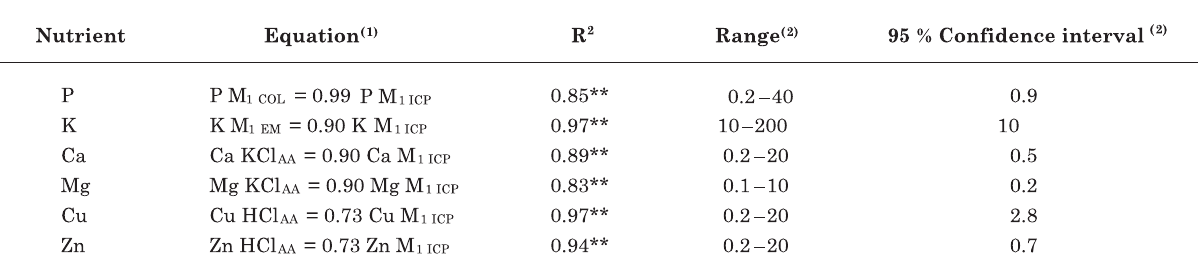
Table 3. Equations, R 2 values and 95 % confidence intervals for all nutrient–extractant relationships developed using intercept regression models